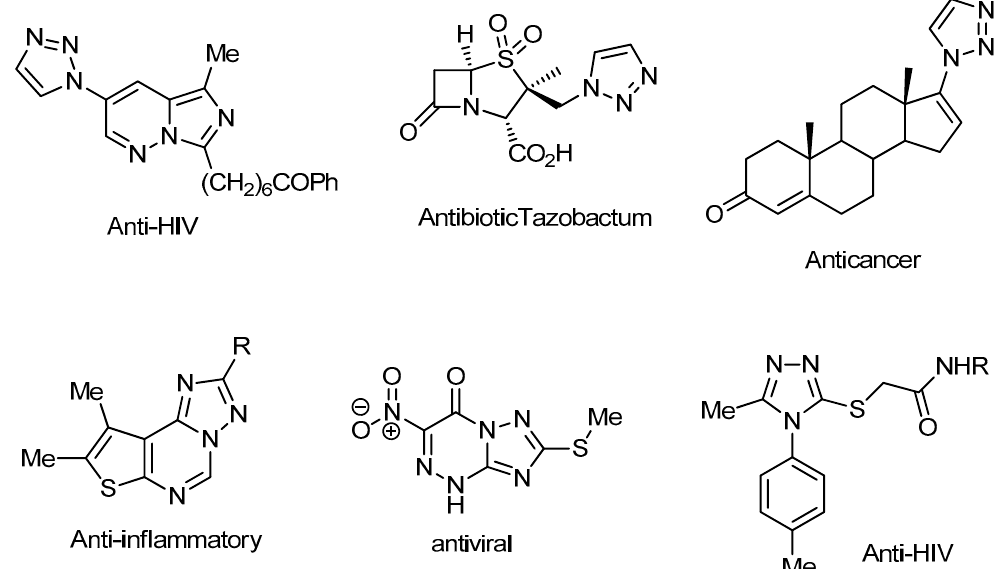
Figure 1. Representative samples of bioactive triazoles.